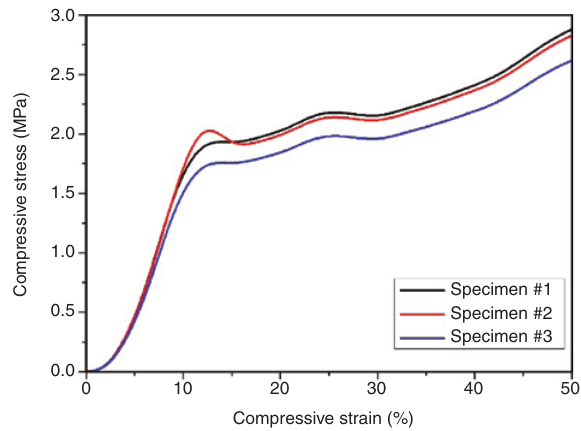
Figure 7: Compressive stress-strain curves of foam filled honey- comb core.